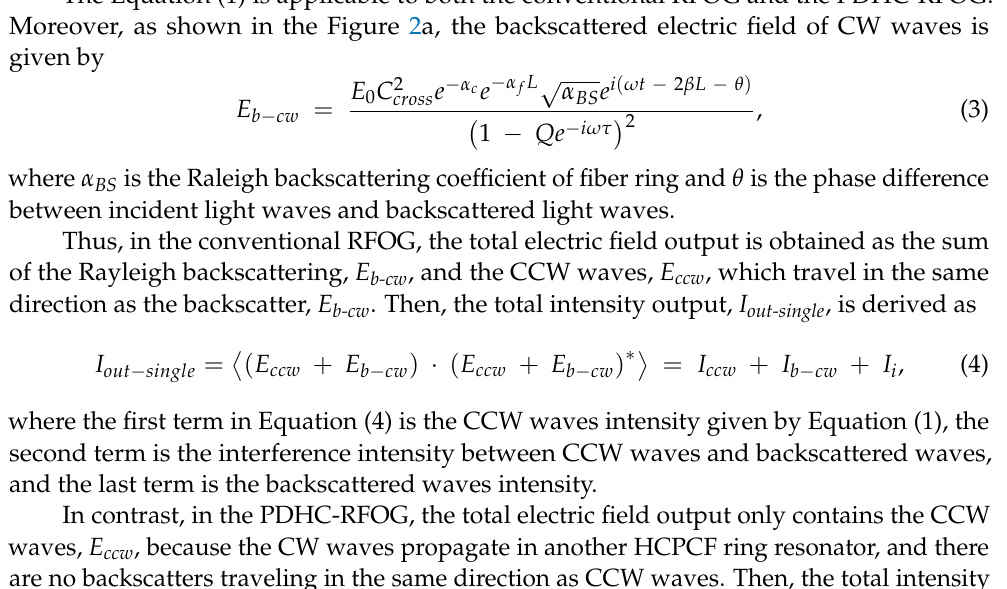
Figure 2. A simplified model for analyzing the Rayleigh backscattering noise in the CCW direction of the RFOG: with ( a ) a single HCPCF ring resonator; with ( b ) the parallel-double HCPCF ring resonator. The Equation (1) is applicable to both the conventional RFOG and the